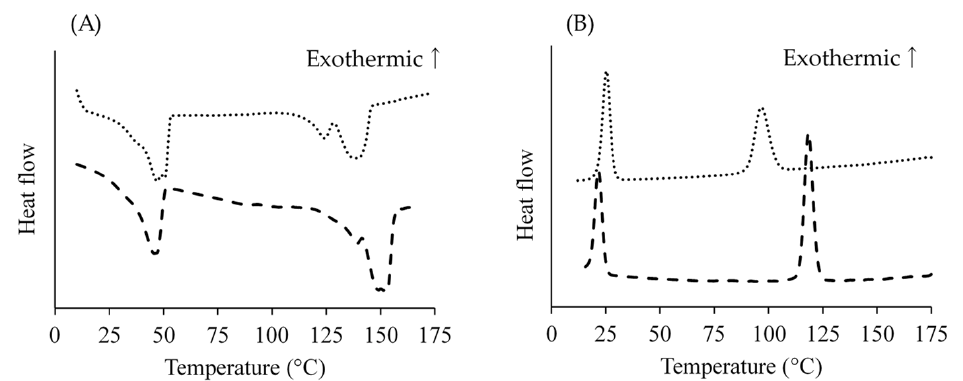
Figure 2. DSC plot of PDLA-PEGuni and PLLA-PEGuni. In panels A and B, the total heat flow was plotted as a function of temperature when the temperature was raised from 10 ◦ C to 160 ◦ C ( A ) and lowered from 160 ◦ C to 10 ◦ C ( B ). The dotted line and dashed line indicate heat flow of PDLA-PEGuni and PLLA-PEGuni, respectively. Table 2. Melting temperature (Tm) and crystalline temperature (Tc) of synthesized PLA-PEG characterized by differential scanning calorimetry .